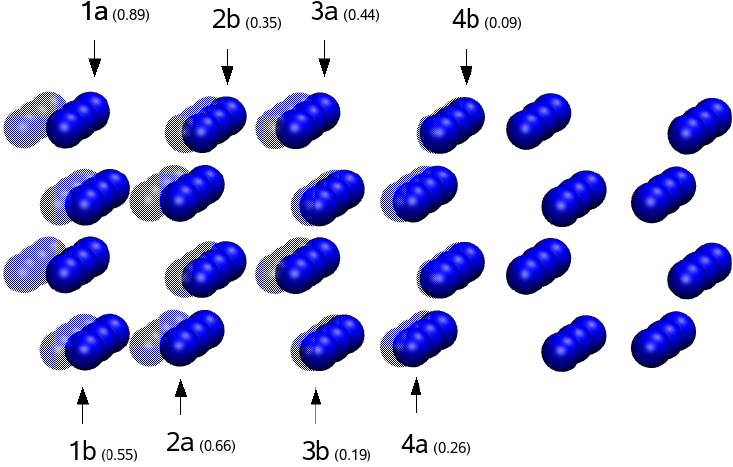
Figure 2. Magnesium free surface before and after geometry optimization. The shadowed atoms represent initial positions of the magnesium before relaxation. In parenthesis are shown distances in ˚A between initial and final positions of the Mg rows (see also Table 1).